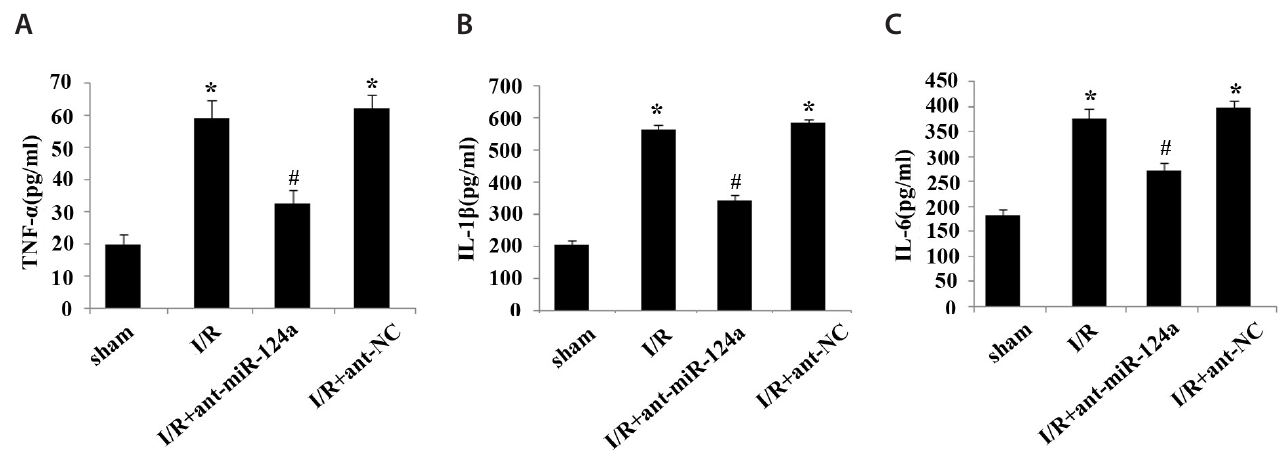
Fig. 3 - Concentration of inflammatory cytokines in cardiac tissue of ischemia reperfusion (I/R) rats. (A) Concentration of tumor necrosis factor alpha (TNF-α) in each group. (B) Concentration of interleukin (IL)-1β in each group. (C) Concentration of IL-6 in each group. Compared with sham group, *P<0.05; compared with I/R group, #P<0.05. ant=antagomir; miR=micro ribonucleic acid; NC=normal control